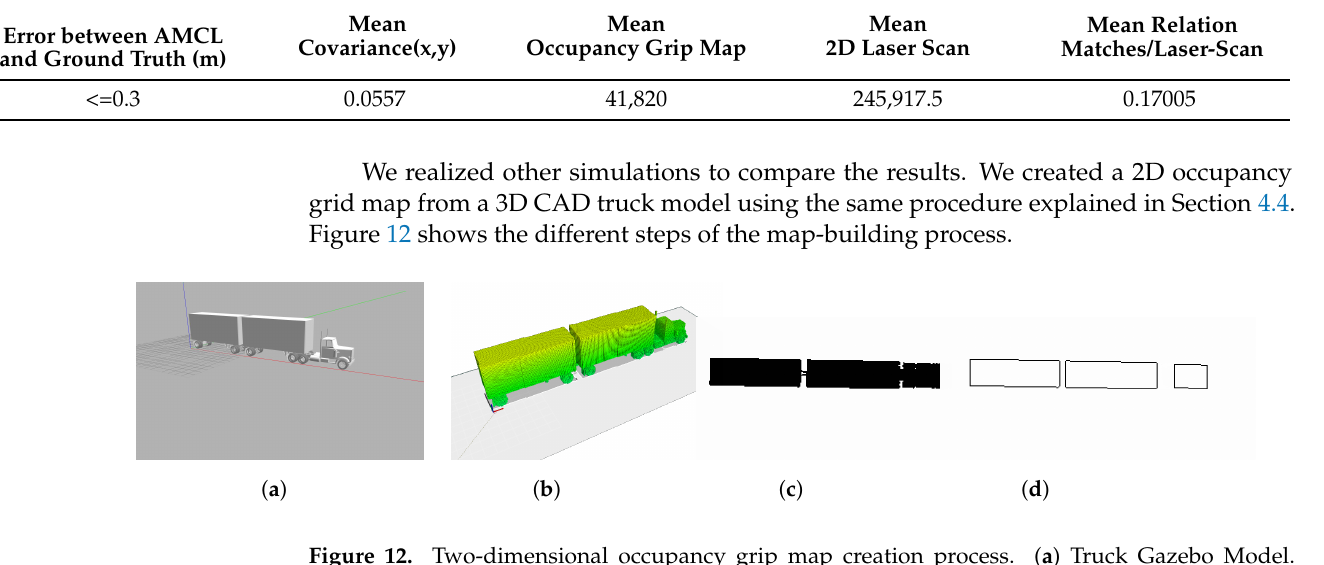
Figure 12. Two-dimensional occupancy grip map creation process. ( a ) Truck Gazebo Model. ( b ) Octomap generated with 0.1 cm voxel resolution. ( c ) Octomap horizontal projection. ( d ) Modified 2D occupancy grip map.